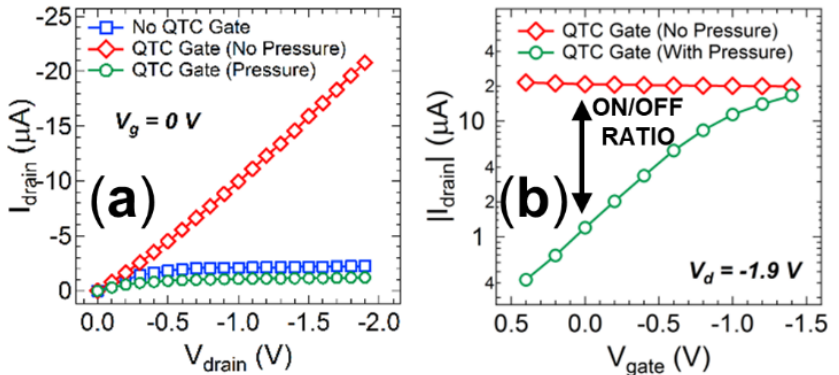
Figure 7. ( a ) A comparison of the current–voltage sweeps with no applied gate voltages for an OTFT